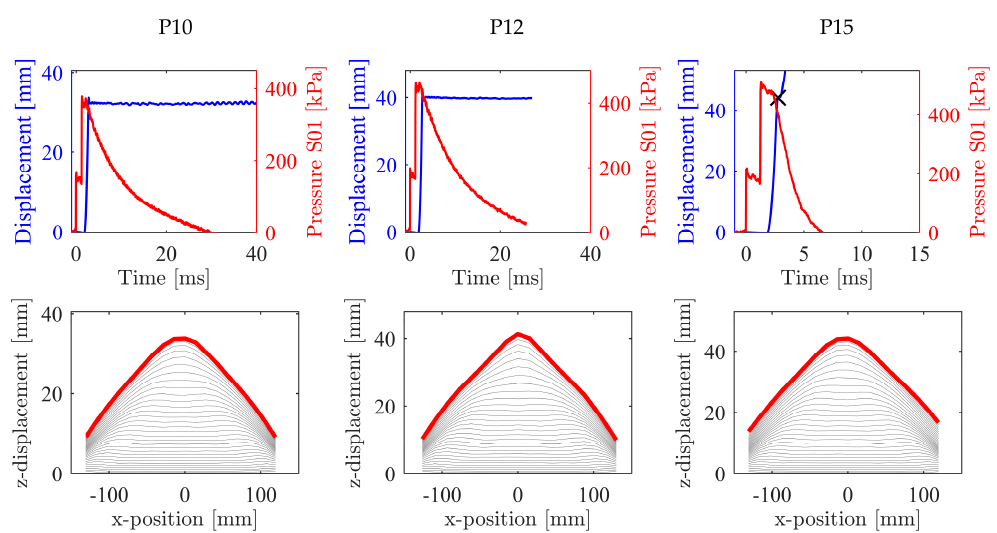
Figure 8. Displacement and pressure vs time (top) and displacement profiles (bottom) for tests on aluminium skins only.